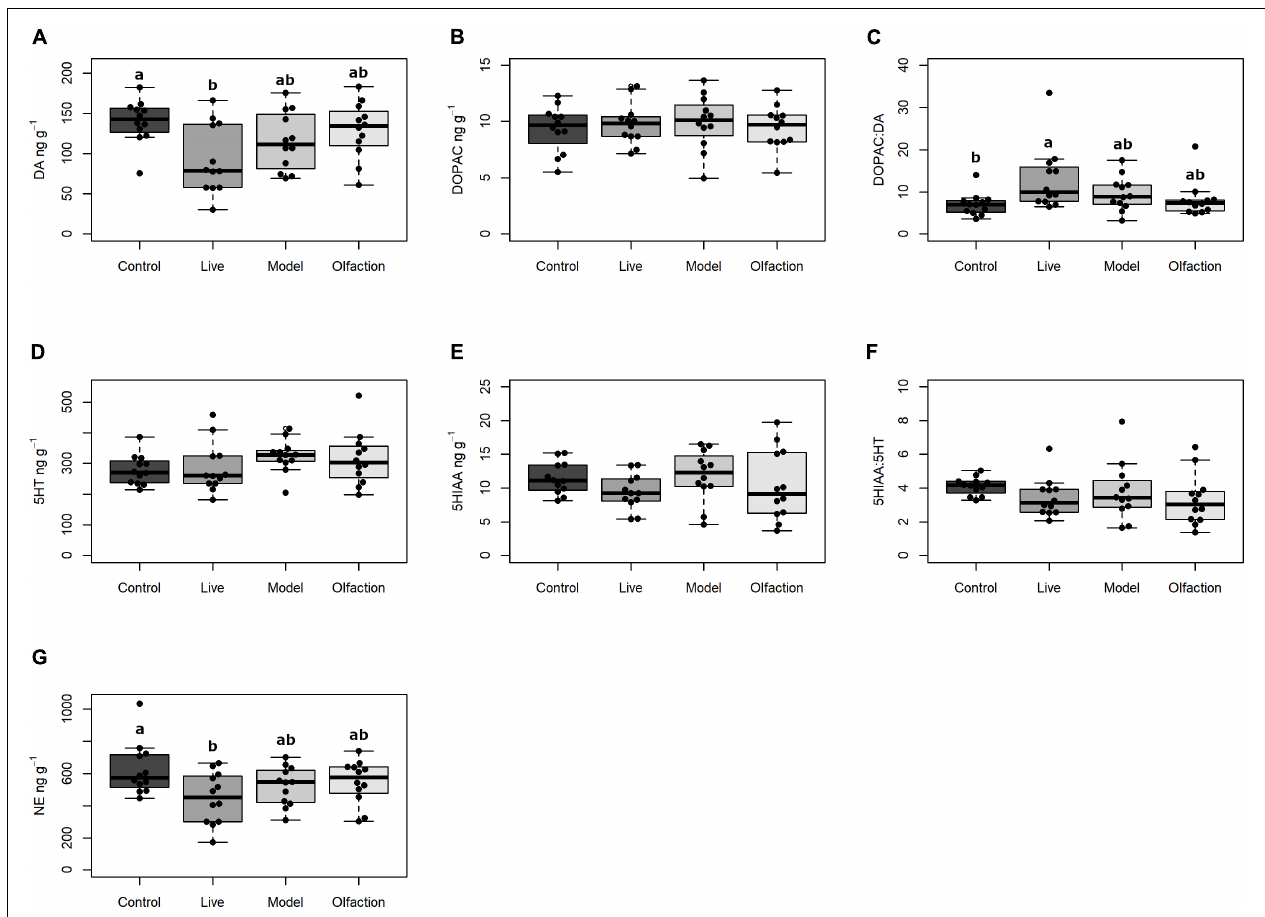
FIGURE 3 | The levels of neurotransmitters (ng g − 1 ) in ft hemisphere of brains from lumpfish ( n = 12) exposed to Live, Model, or Olfaction treatments in addition to a Control. Neurotransmitters include (A) DA (dopamine), (B) DOPAC (3,4-dihydroxyphenylacetic acid), (C) the DOPAC:DA turnover ratio, (D) 5HT (serotonin), (E) 5HIAA (5-hydroxyindoleacetic acid), (F) the 5HIAA:5HT turnover ratio, and (G) NE (Norepinephrine). Treatments that share a letter were not significantly different ( p < 0.05).